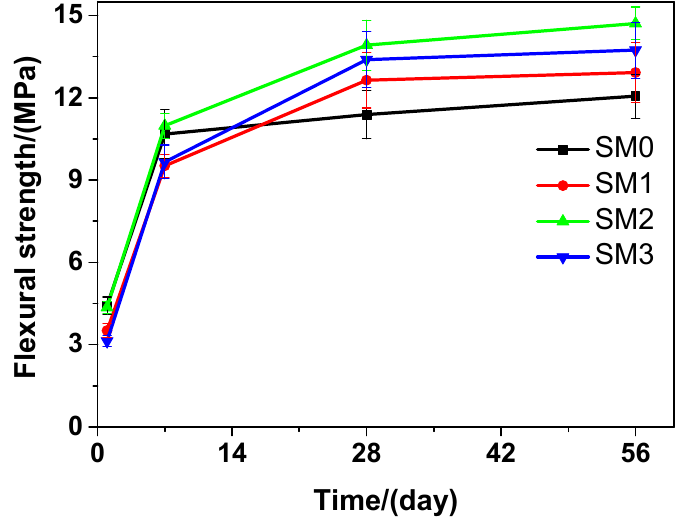
Figure 6. The flexural strength of siliceous sacrificial mortar at different curing time.